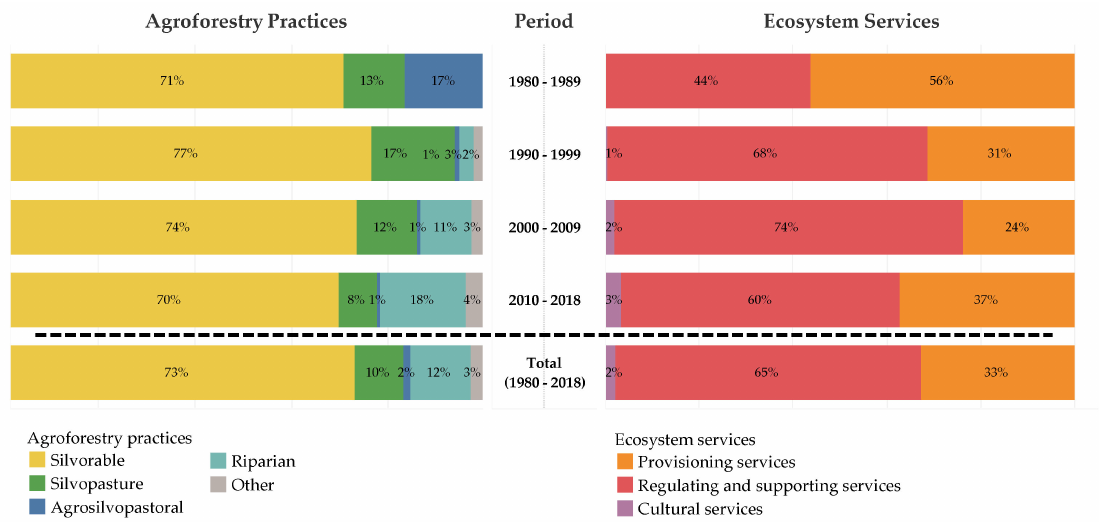
Figure 5. Ratio of the articles on agroforestry practices and ecosystem services by